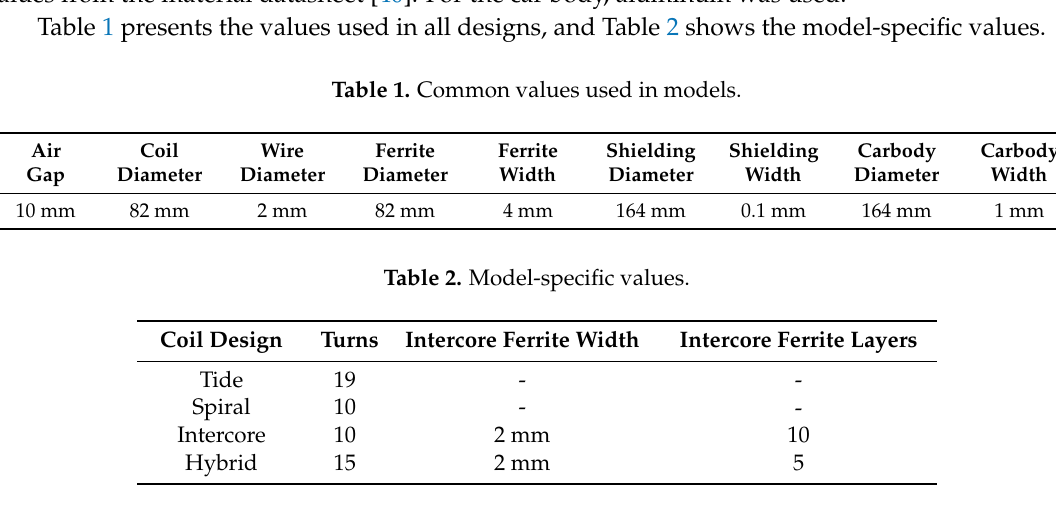
Figure 7. Shielding film.